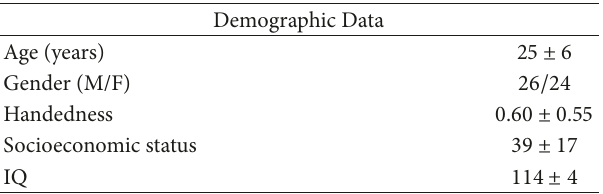
Table 1: Demographic data of the healthy cohort (mean ± standard